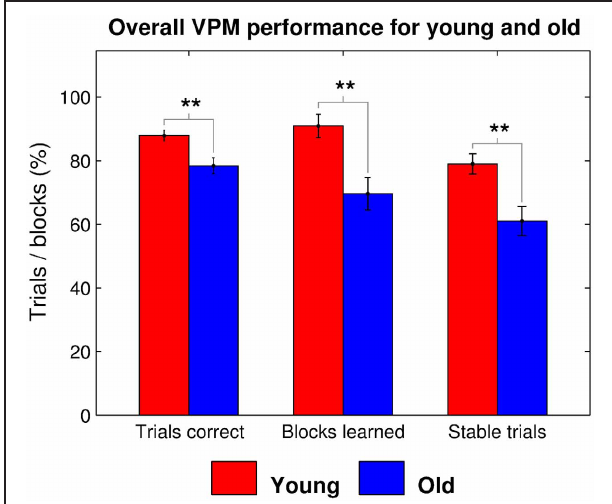
FIGURE 2 | Overall virtual plus maze task performance, as measured by the mean percentage of trials correct, blocks learned, and stable trials for young (red) and old (blue) participants. Significant group differences are indicated at the ∗ 0 . 05, ∗∗ 0 . 01, and ∗∗∗ 0 . 001 levels.